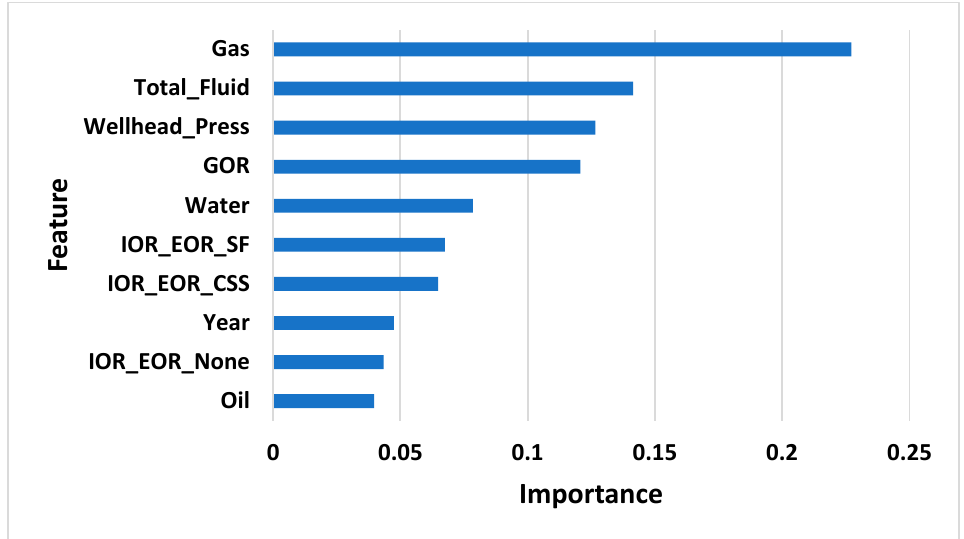
Figure 11. Critical AL selection features.